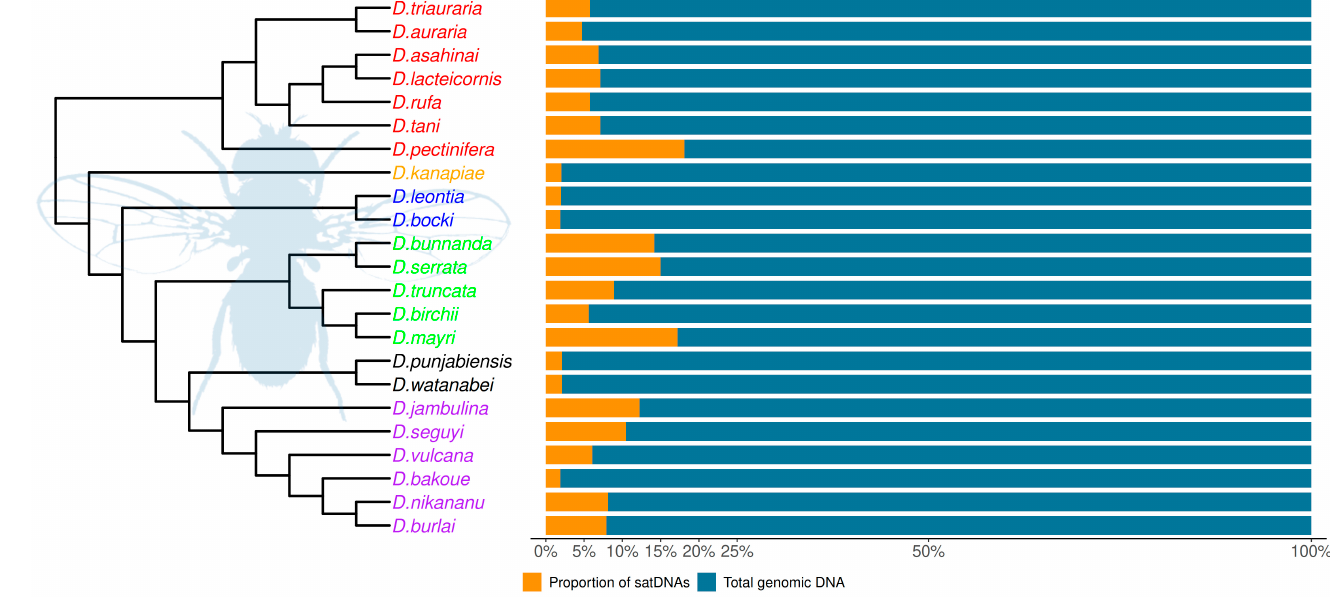
Figure 5. SatDNA genomic proportions in the 23 analyzed species from the montium group. The phylogenetic tree was reconstructed according to Conner et al. [30]. Species names are colored according to the subgroups they belong to (see Figure 1).